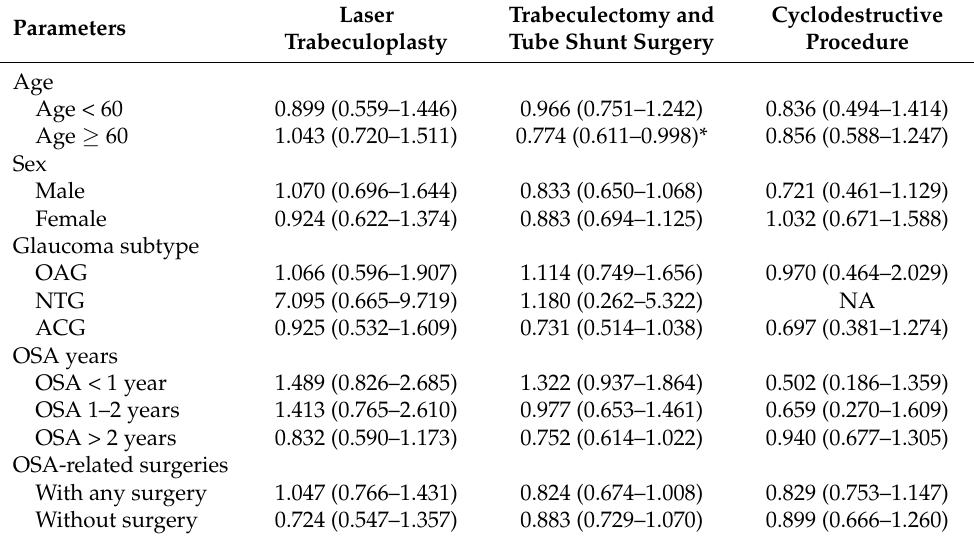
Table 3. Stratified analysis for different parameters in glaucoma